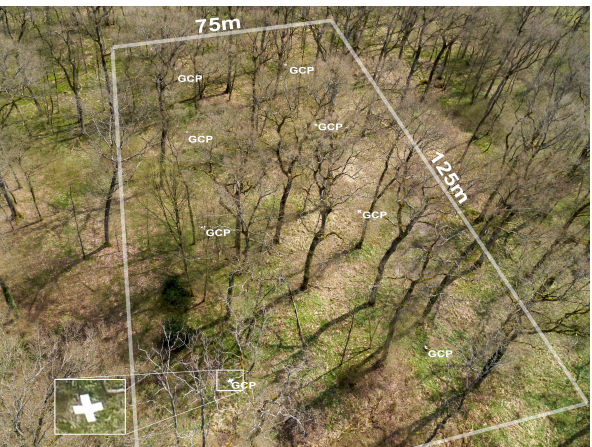
Figure 1: View of the study area including ground control points (highlighted in the lower left).